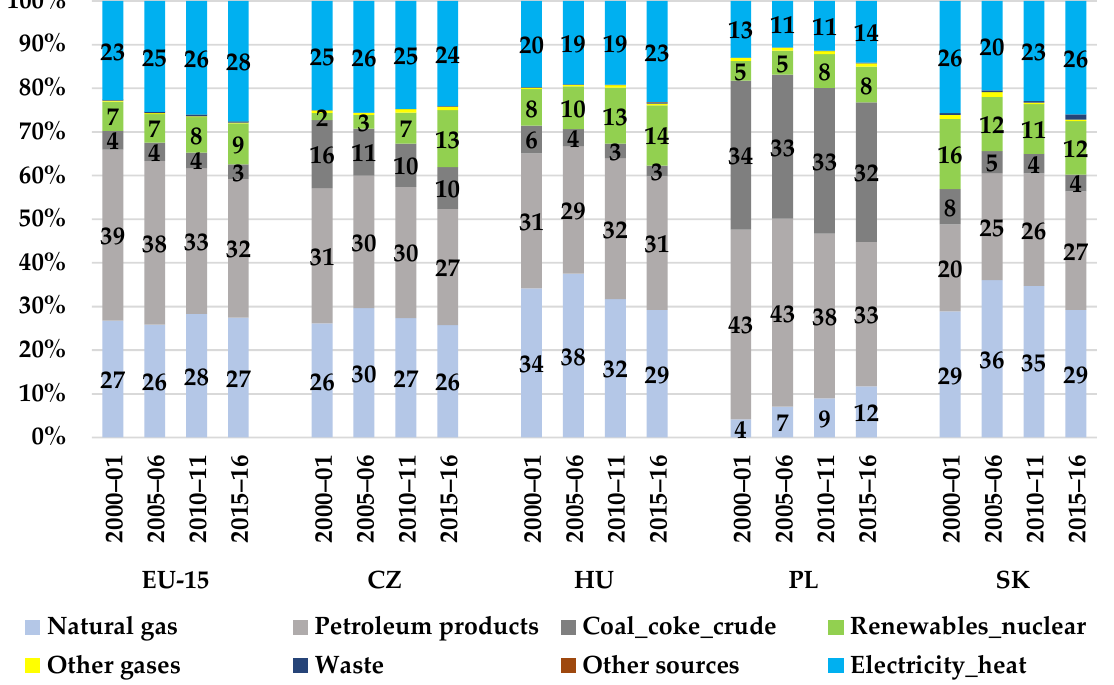
Figure 5. Structure of the sources of energy consumption in food production systems. Source: Own calculations based on WIOD Environmental Accounts and WIOD national input–output tables.